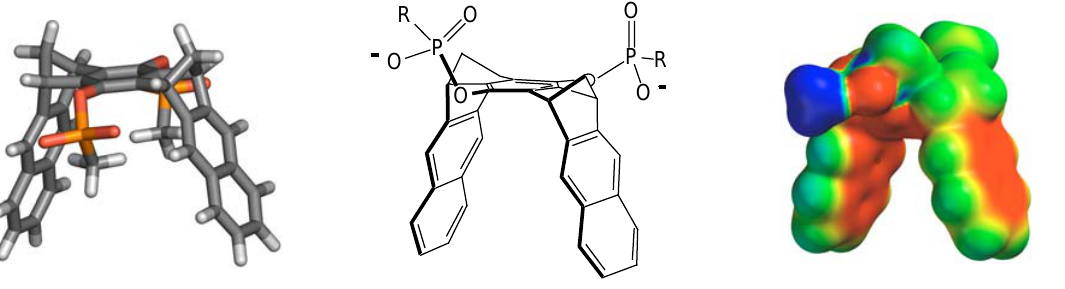
Figure 1. Calculated as well as Lewis structure and electrostatic potential surface of the water- soluble molecular clip 1